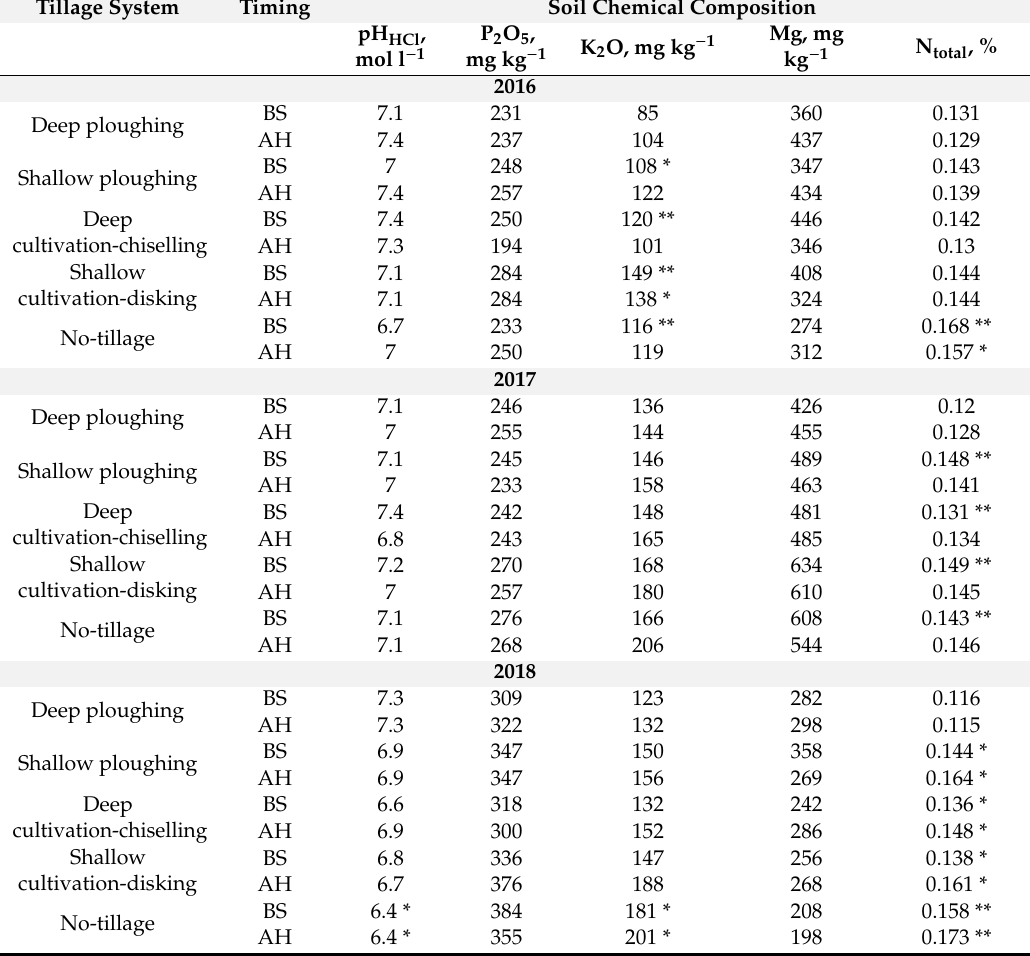
Table 3. The e ff ect of the tillage systems on the soil chemical composition (0–15 cm soil